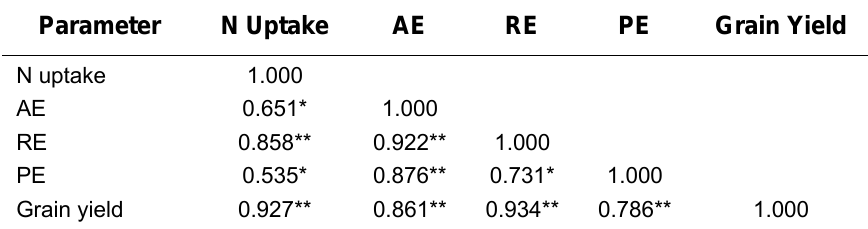
Simple Correlation Matrix Showing the Relationship of N Uptake by Rice, AE, RE, and PE with Grain Yield